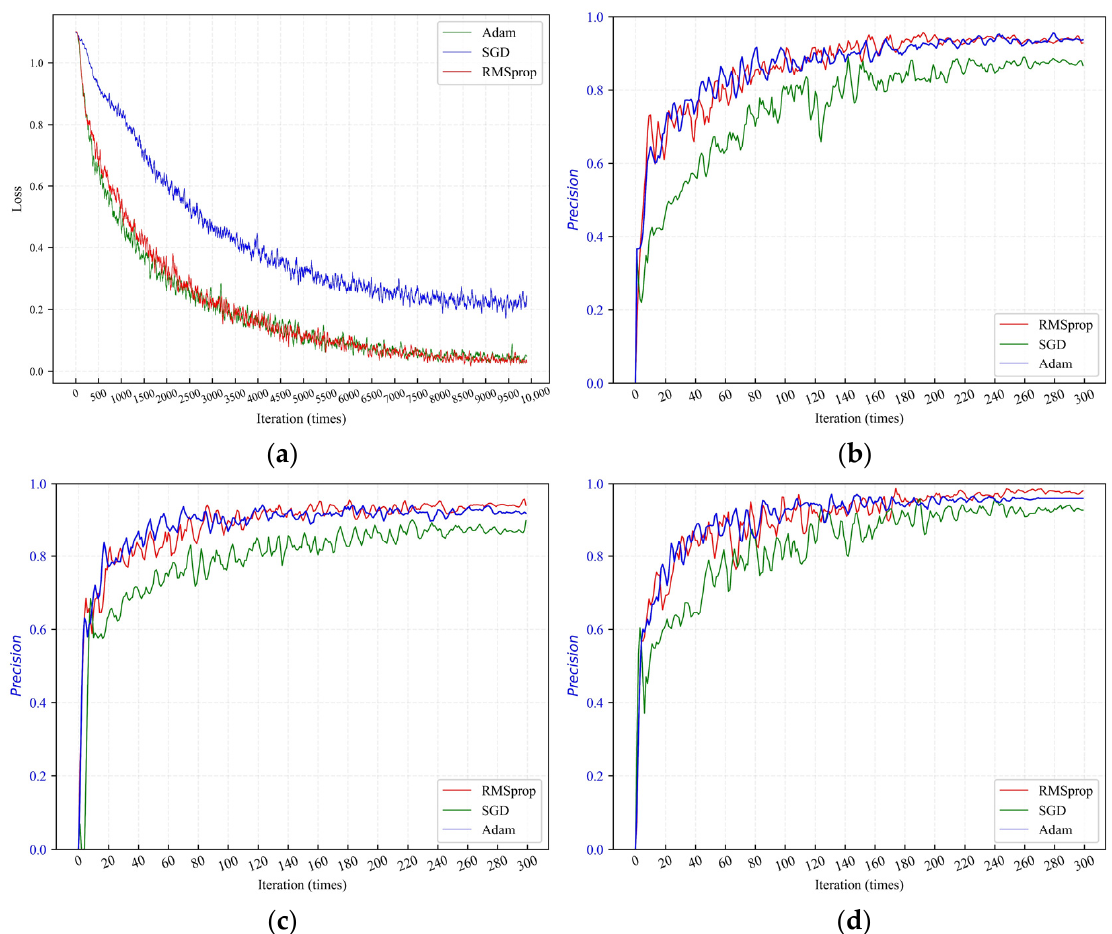
Figure 17. ( a ) Training loss of MobileNetV2 under three optimizers; ( b ) classification precision of metamorphic rock under three optimizers; ( c ) classification precision of sedimentary rock; and ( d ) classification precision of volcanic rock.